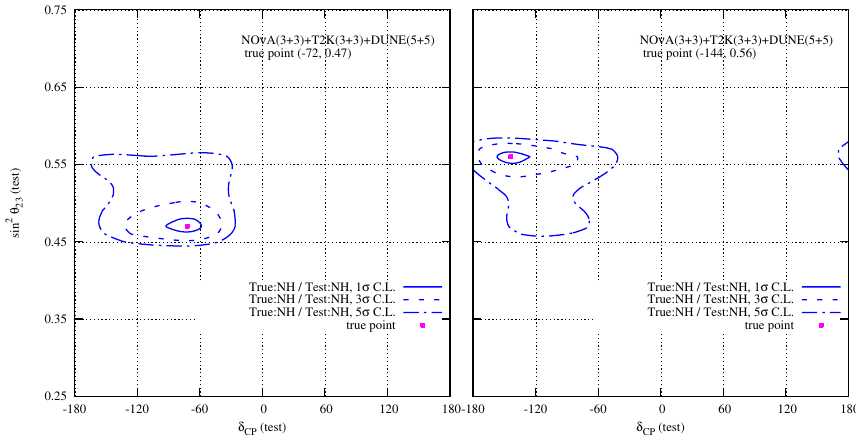
Figure 5 . Regions of sin 2 (cid:18) 23 vs. (cid:14) cp parameter space. The left (right) column represents for LO (HO) for NO (cid:23) A (3 (cid:23) + 3(cid:22) (cid:23) ) + T2K (3 (cid:23) + 3(cid:22) (cid:23) ) + DUNE (5 (cid:23) + 5(cid:22) (cid:23) ).